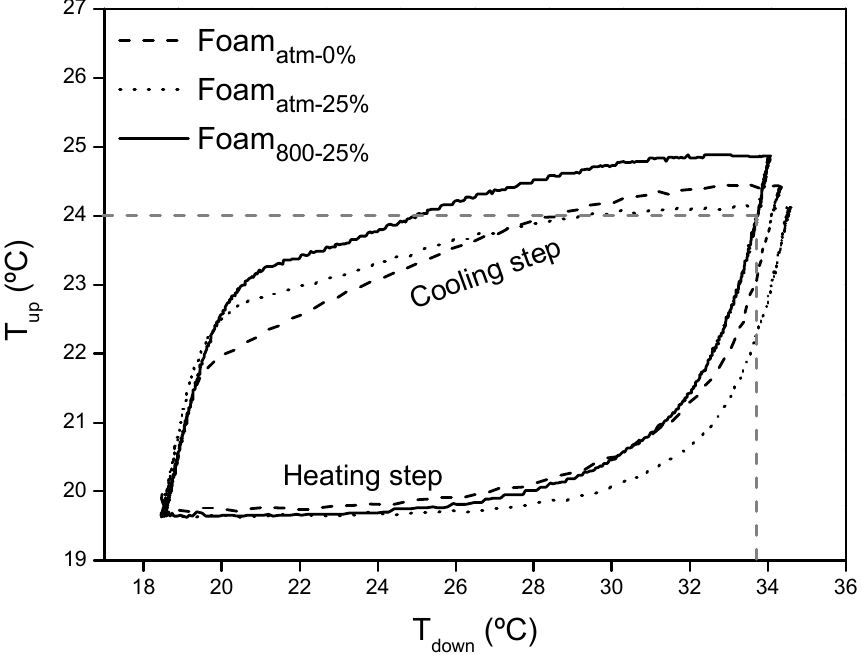
Figure 13. T up as function of T down registered in the thermal behavior test.